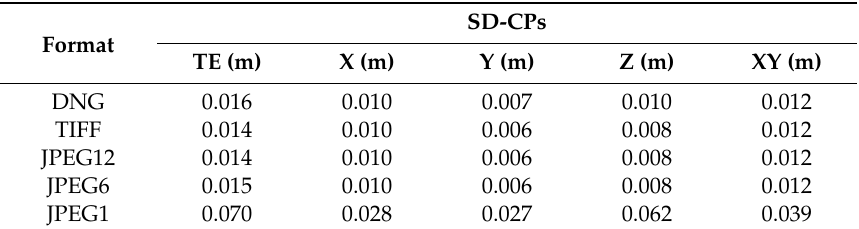
Table 8. Evaluation of the accuracy on CPs—Test site 3.